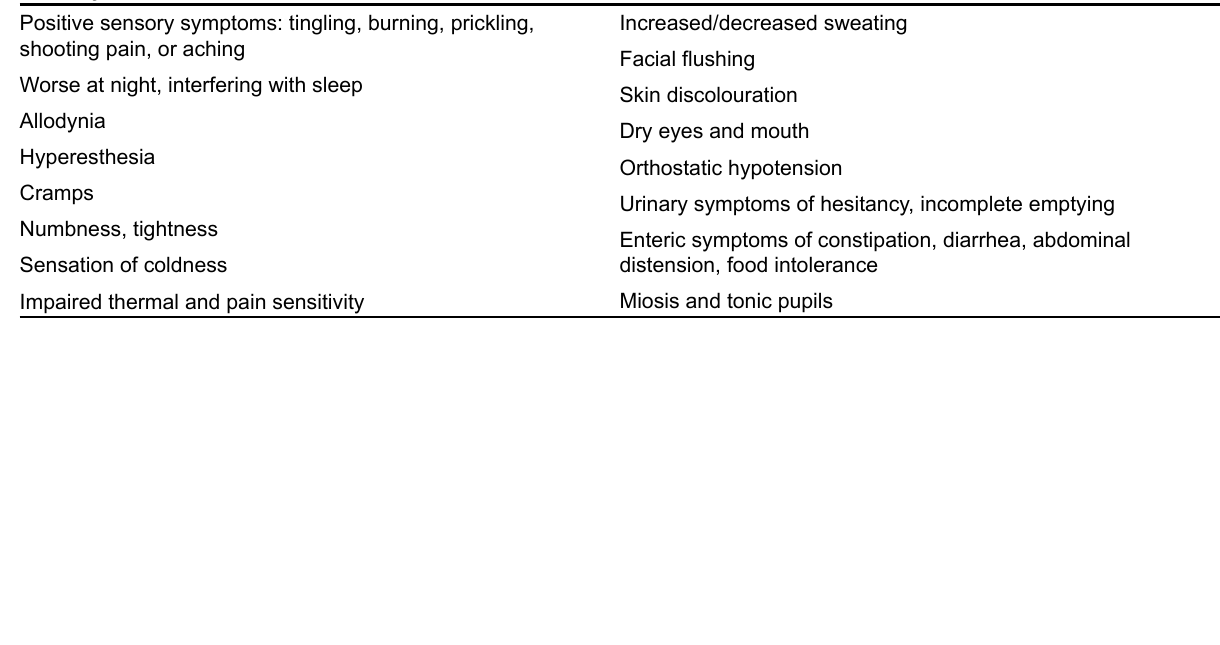
Figure 1. Algorithm of diagnostic work-up for patients with suspected SFN. EMLA: eutectic mixture of local anesthetics; PET: positron emission tomography; CT: computerized Table 1. Clinical features of SFN in the presence of normal muscle strength, proprioception and tendon reflexes Sensory